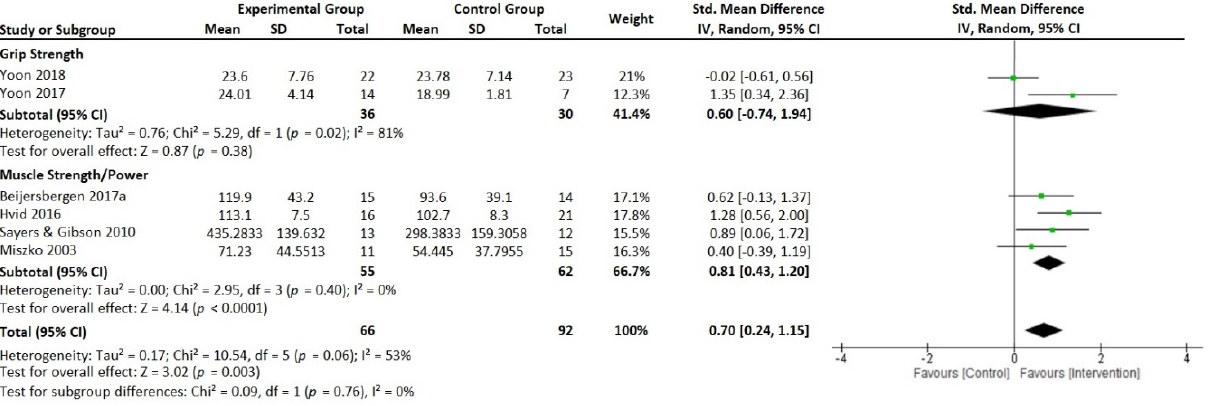
Figure 3. Forest plot presenting standardized mean difference and 95% confidence intervals from studies reporting high-speed resistance-training-induced changes in neuromuscular function between the intervention groups and the control groups. IV, independent variable; CI, confidence interval; SMD, standardized mean difference [54,57,61,65,66,67].